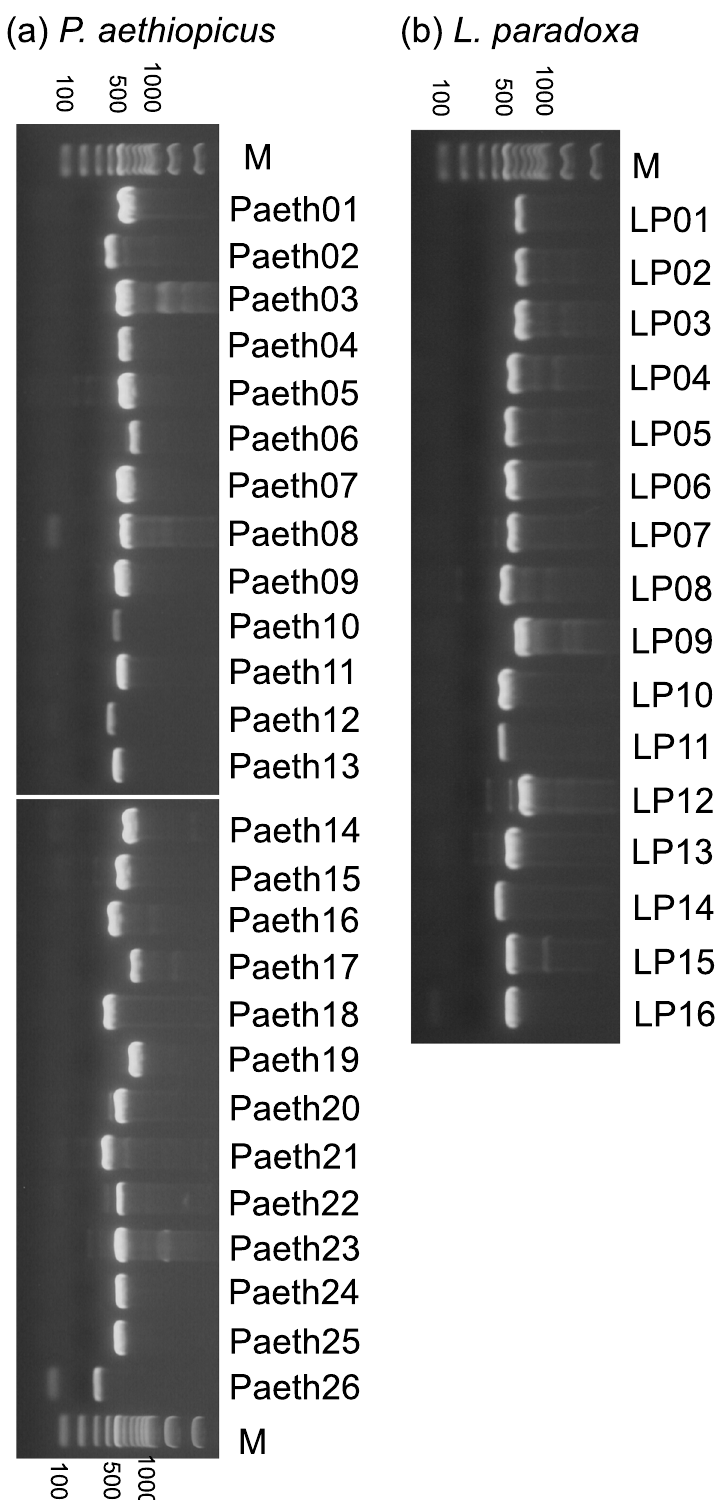
Fig. 5 RT-PCR analysis for the expression of V1Rs in the olfactory organ of P. aethiopicus ( a ) and L. paradoxa ( b ). All V1Rs analyzed in this study are expressed in the olfactory organ. Lane M: FastGene100bp DNA